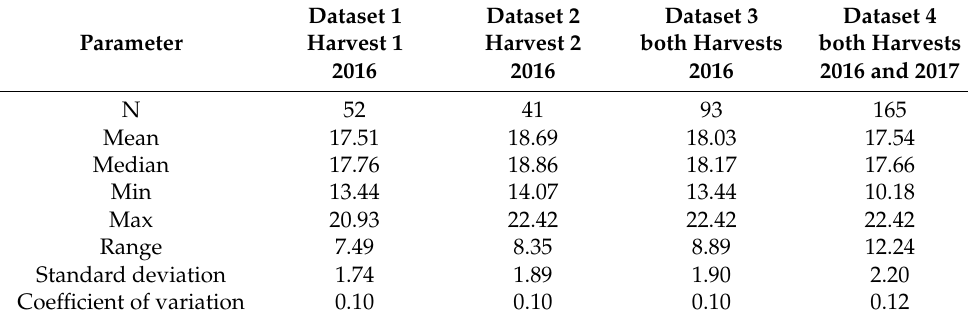
Table 2. Statistical analysis of sample sets for the grape TSS content.